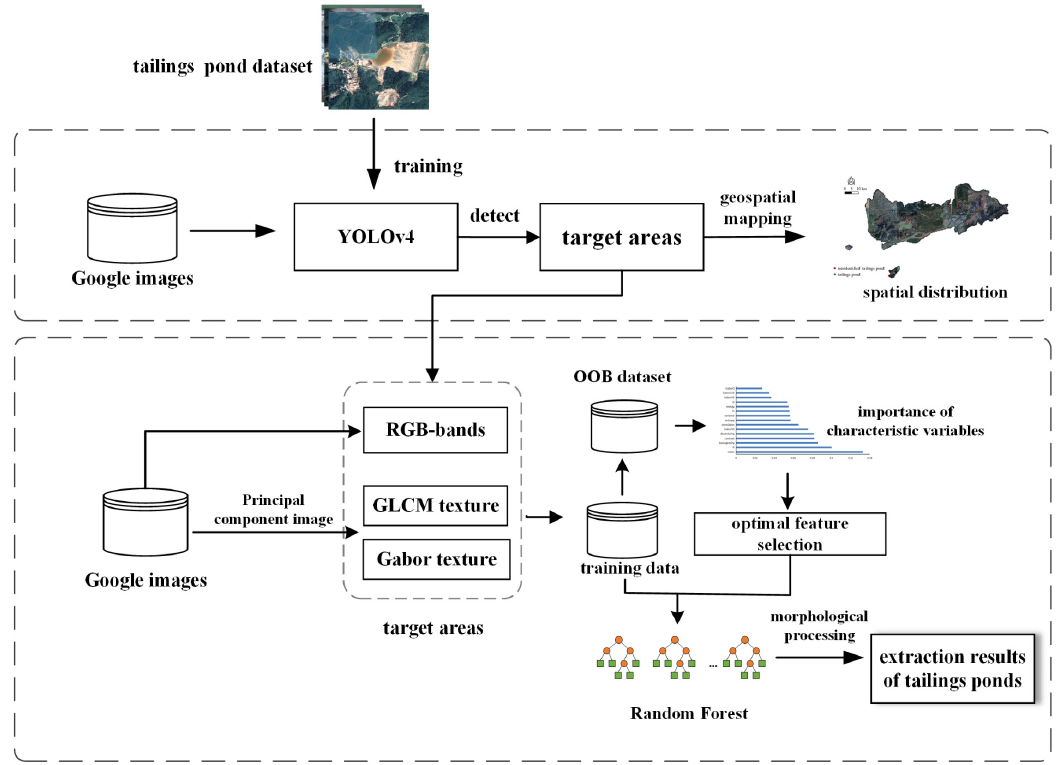
Figure 1. The flowchart of tailings pond extraction combining You Only Look Once (YOLO)v4 and random forest.